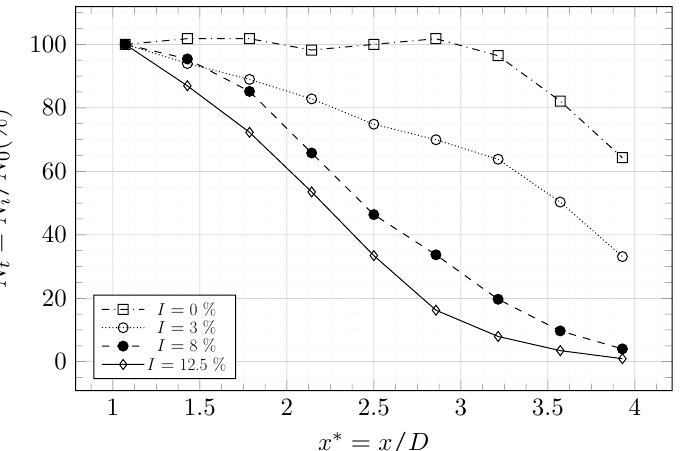
Figure 27. LBM-LES simulation of the tidal turbine at TSR = 3.67. Intersections rate N t at the segments center for I = [ 0,3,8,12.5 ]